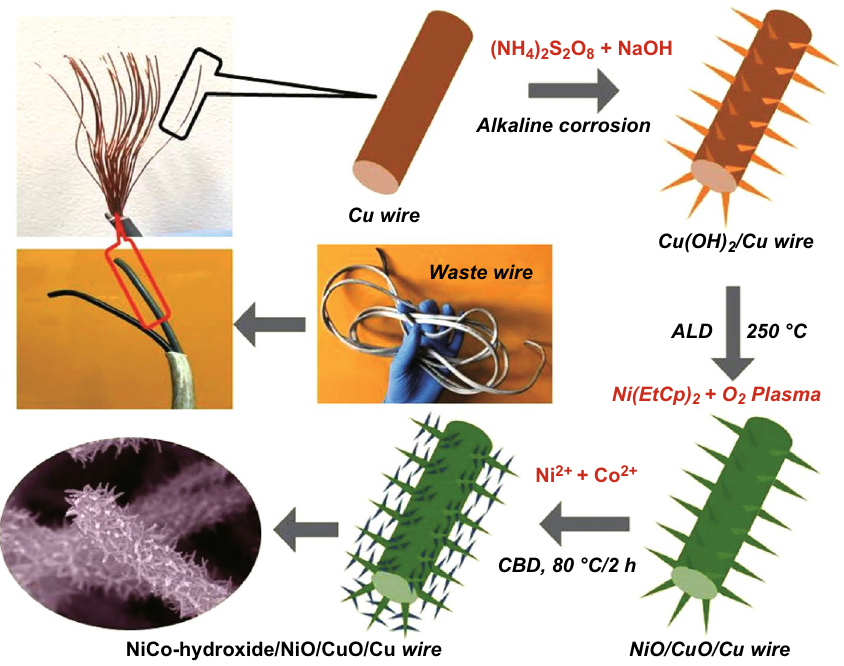
Fig. 1 Schematic illustration of the preparation of dendritic‑structured NiCo‑hydroxide/NiO/CuO/Cu electrode using e‑waste Cu wires for the RAB